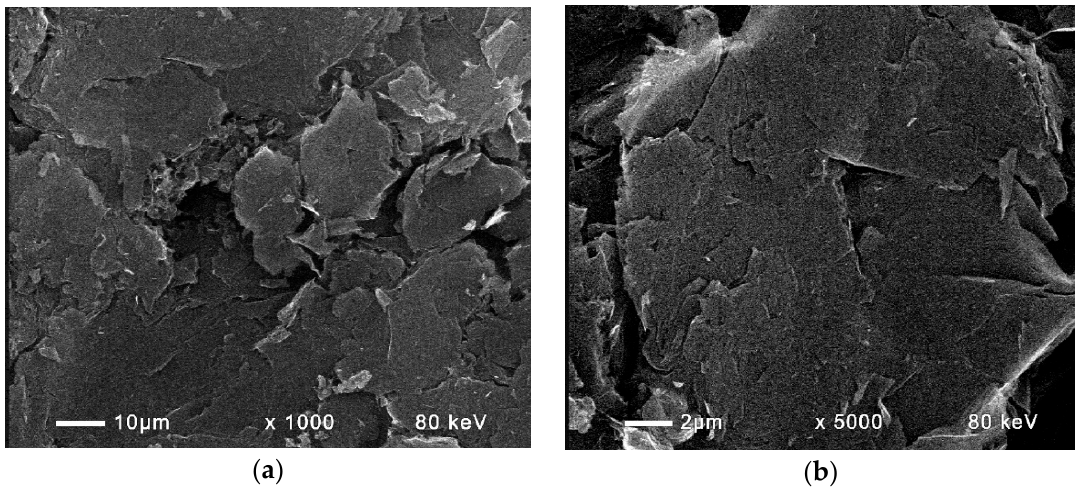
Figure 4. SEM images at different magnifications of sintered graphite electrode. ( a ) magnification ×1000; ( b ) magnification ×5000.